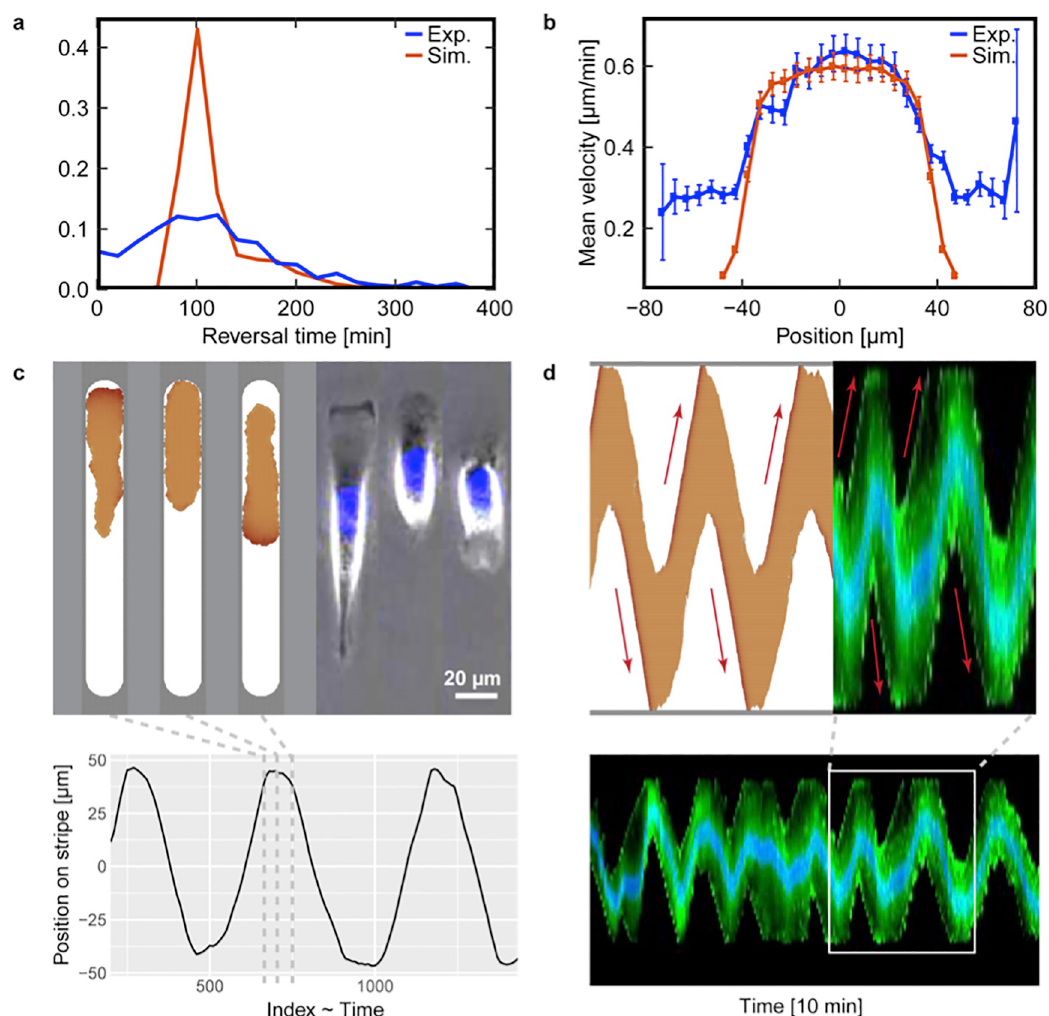
Fig 5. Comparison of computer simulations and experimental results. The microlane length is fixed at 170 μ m with a round tip geometry. (a) Reversal time distributions of simulated and experimental cells. (b) Spatial mean absolute velocity distributions of simulated and experimental cells. (c) The extended Cellular Potts model features an internal polarization field. Our simulations reproduce the distinct run and rest phenotypes and yield cell center-of-mass trajectories that show quasi-periodic behavior (bottom); experimentally obtained cell trajectories are indicated on the upper right. (d) Comparison between the kymograph of a LifeAct-GFP transfected MDA-MB-231 cell with nuclear staining (bottom) and the kymograph of a simulated cell. Top: Zoom-in to a region that contains two periods of oscillation. Top left: Simulated cell. Top right: Experimental cell. Bottom: Zoom-out to the kymograph of an experimental cell that performs many periods of oscillation. Red arrows indicate the direction of cell motion. A video of the moving LifeAct-GFP transfected MDA-MB-231 cell can be found in “S4 Video”.